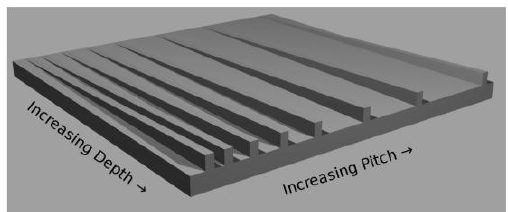
FIGURE 3: 8μm grooves etched in silicon using a ppHex gradient mask. Groove pitch increases in 0.5μm steps from bottom to top, whilst groove depth increases from left to right following the profile shown in fig 2.